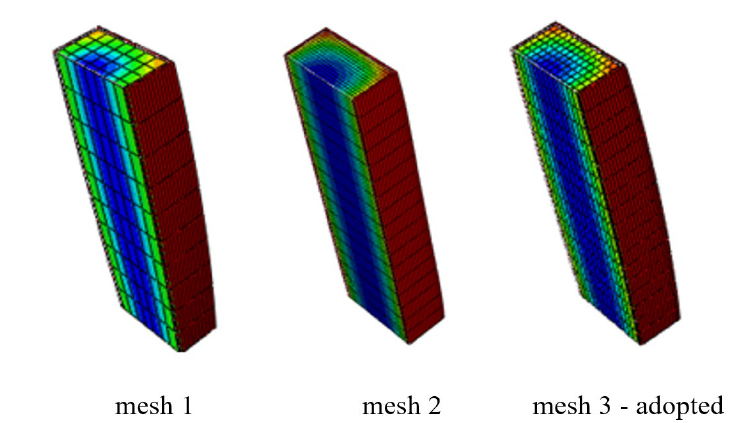
Figure 2. Finite element mesh density levels.